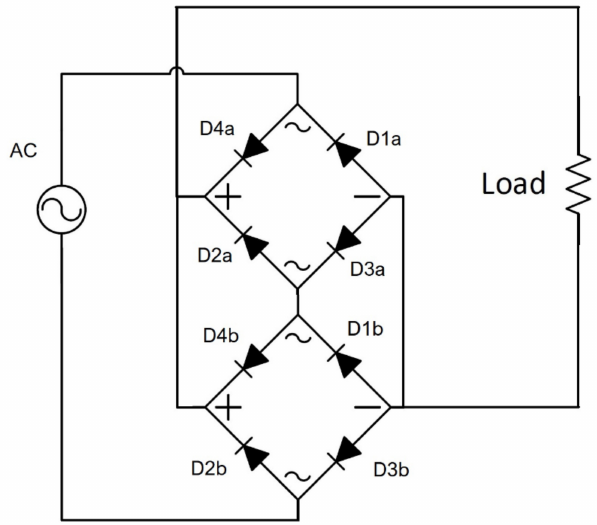
Figure 4. Multicell bridge ISOP